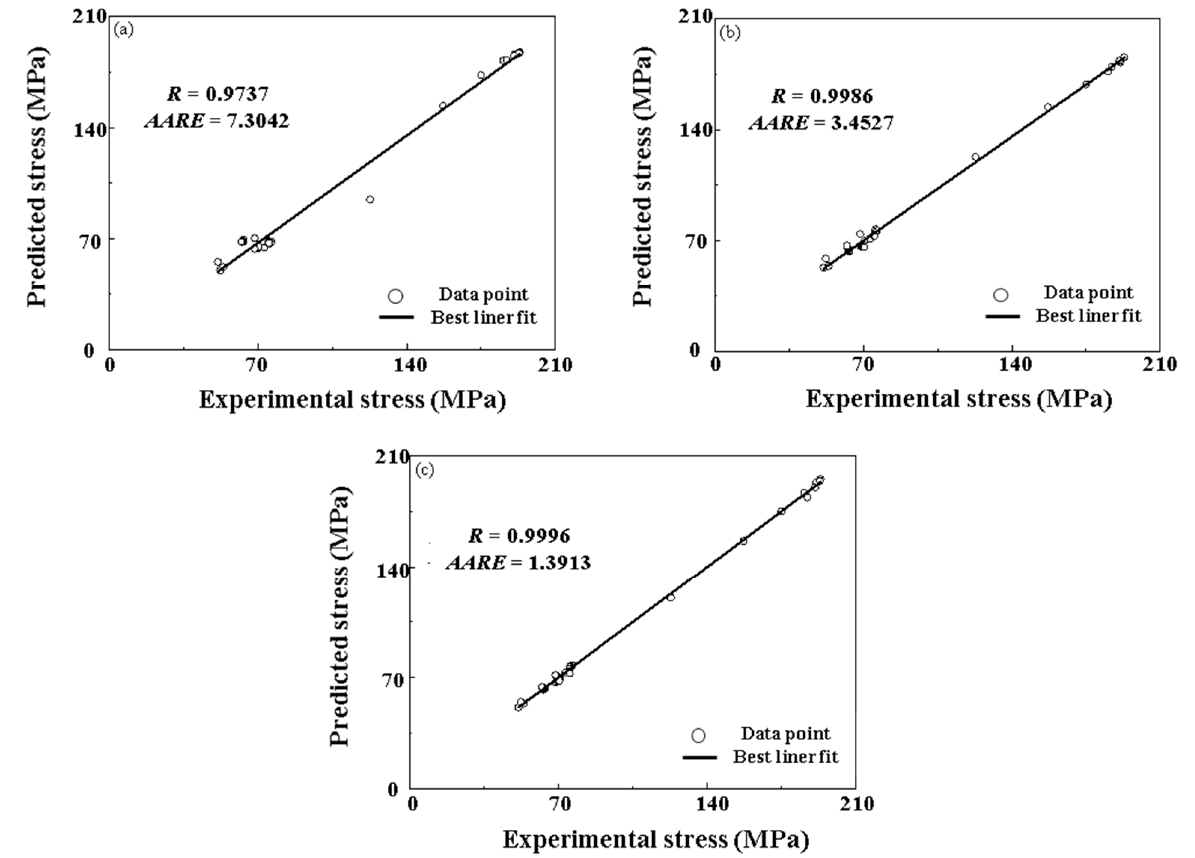
Figure 12. The correlation relationships among the predicted and experimental true stress for the ( a ) the semi-physical model with improved Arrhenius-Type, ( b ) BP-ANN, and ( c ) PSO-BP integrated model.